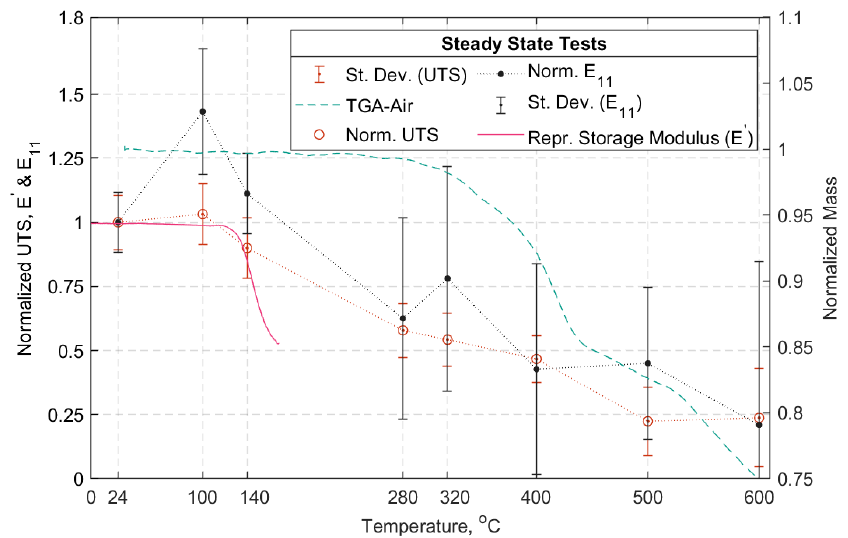
Figure 21. Left : Normalized UTS, normalized elastic modulus ( E 11 ), and normalized storage mod- ulus (representative E ’) vs. temperature (°C). Right : Normalized mass vs. temperature (°C). SS modulus (representative E ’) vs. temperature ( ◦ C). ( Right ): Normalized mass vs. temperature ( ◦ C). tests. SS